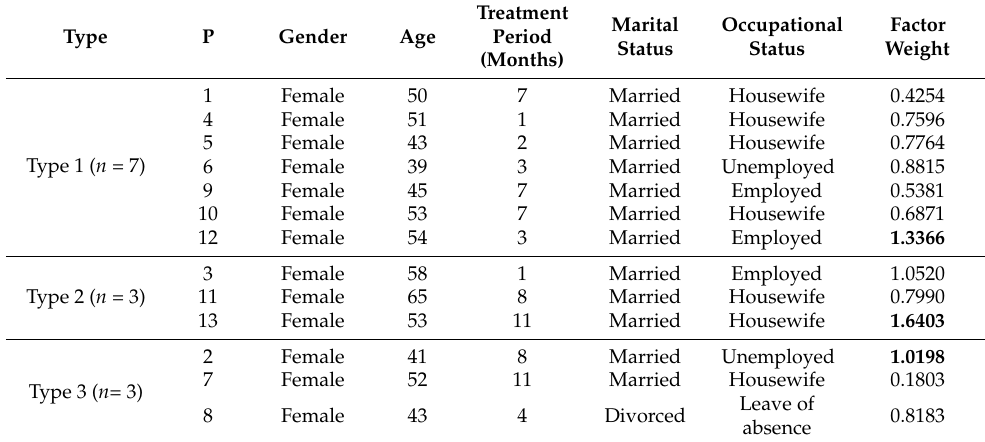
Table 5. P sample and (P)